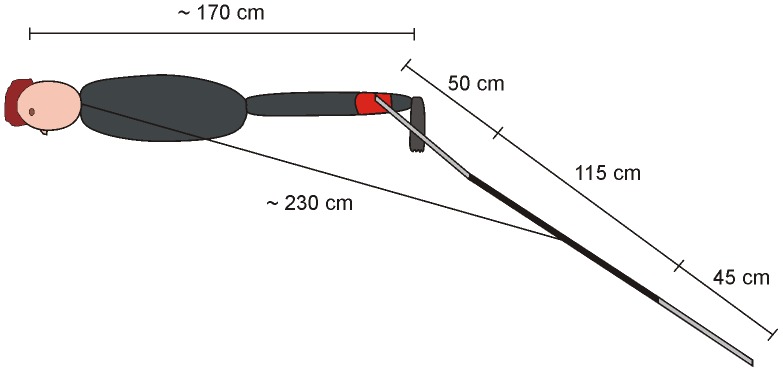
Schematic representation of a diver wearing a Shark Shield Freedom7™.The electrodes of the Shark Shield are represented in light grey. The electronic component that attaches to the ankle of the diver is represented in red.